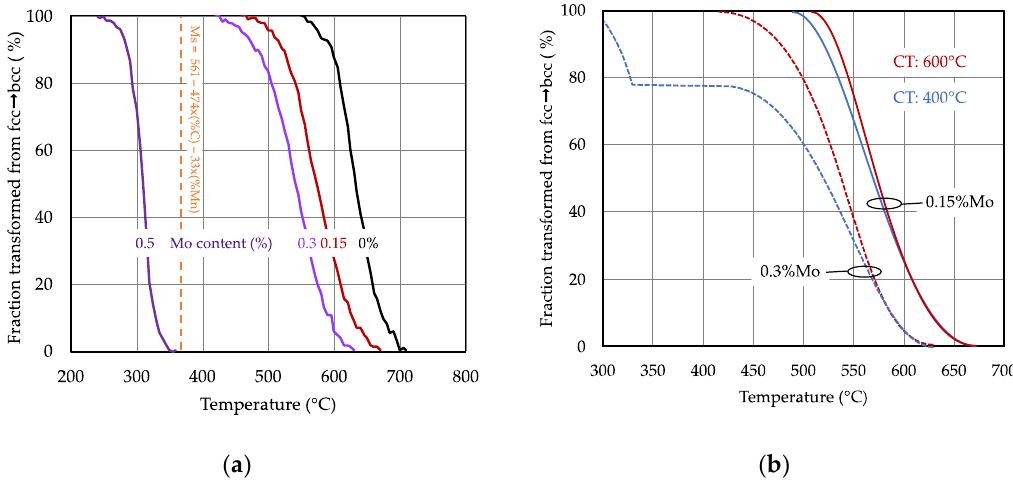
Figure 5. ( a ) Effect of molybdenum alloy content on the fcc-bcc transformation behavior (coiling temperature: 600 °C, heating rate: 10 °C/s, peak temperature: 875 °C, cooling rate: 10 °C/s); ( b ) influence of coiling temperature (CT) on the transformation behavior of 0.15 and 0.3% Mo alloyed steel (curves smoothened for clarity).